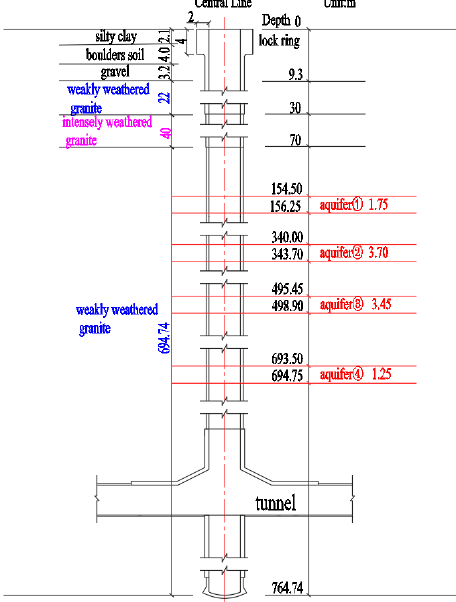
Figure 5. Geological and hydrological conditions of No. 1 vertical auxiliary shaft.